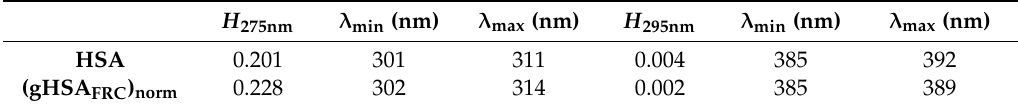
Table 1. Parameter H calculated for Trp-214 and Tyr residues of human serum albumin, at λ ex = 275 nm and λ ex = 295 nm.